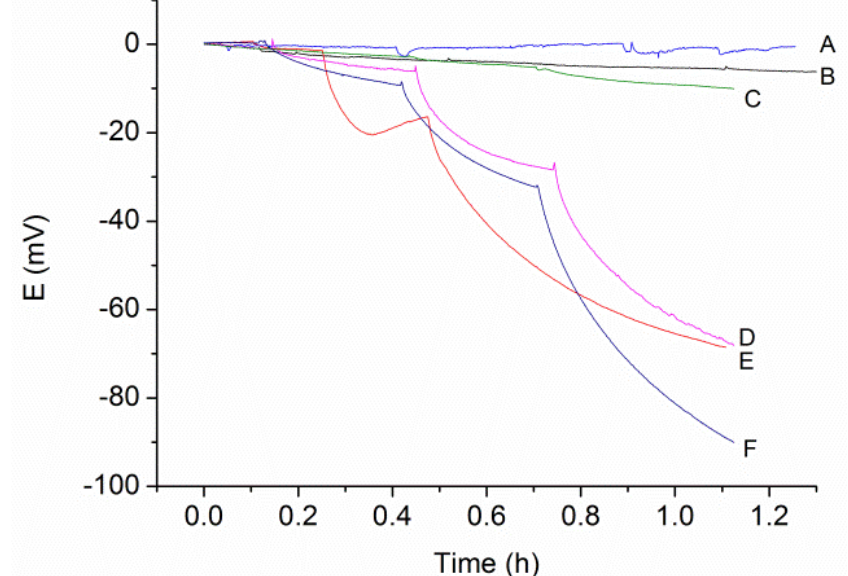
Figure 2. Potentiometric responses to BSA, GOx and casein adsorptions on the non-modified and AuNPs modified GC electrodes (1, 10, and 100 μ g mL − 1 of BSA, GOx and casein were added in series). A, GOx; B, BSA and C, casein adsorption of non-modified GC electrodes. D, GOx; E, BSA and F, casein adsorption on AuNPs modified GC electrodes.